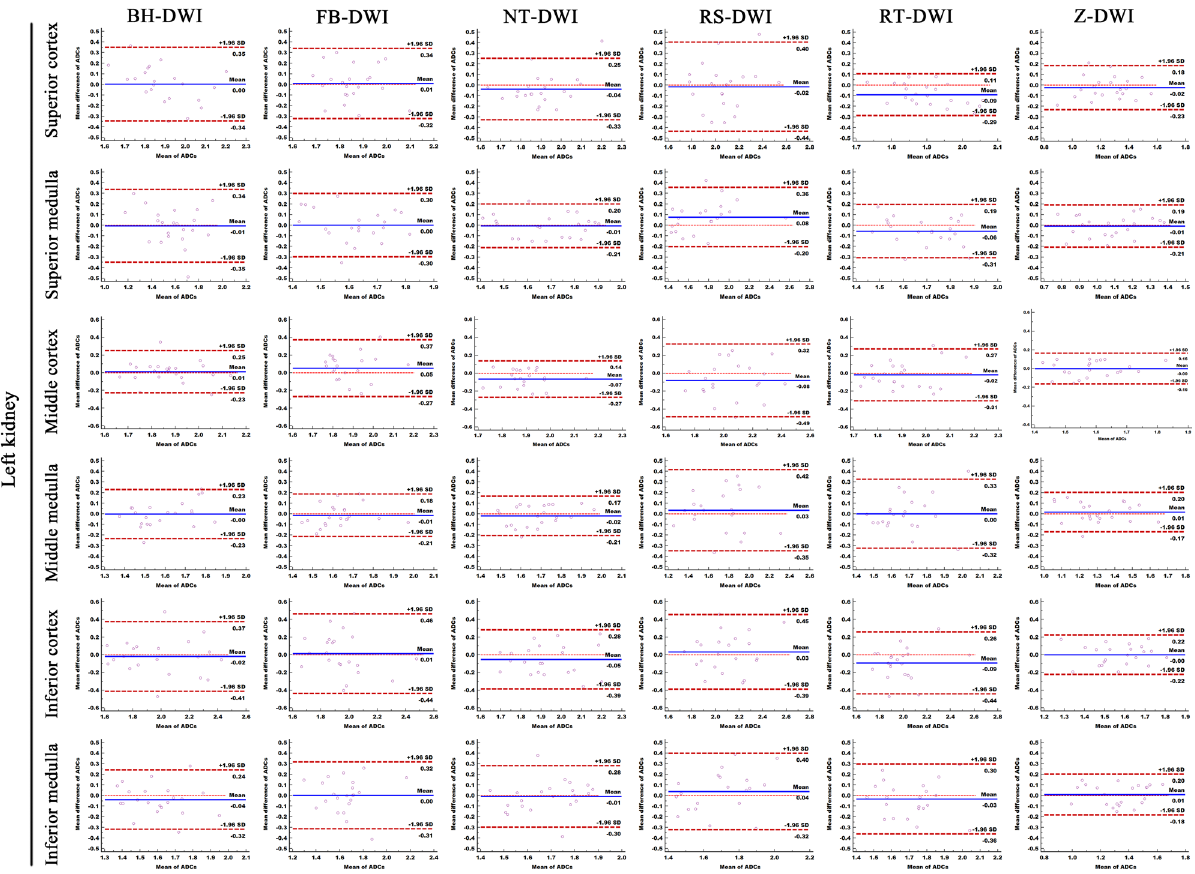
Figure 2. Comparison of ADC measurement repeatability of the six different DWI sequences in left kidney. The Bland–Altman plots of ADC measurements presented that Z-DWI had the lowest lowest LOA (0.031– 0.051 × 10 −3 mm 2 /s) (near zero) than all other sequences at almost all measurement points (6 anatomic locations of left kidney), which indicates that Z-DWI has the best ADC measurement